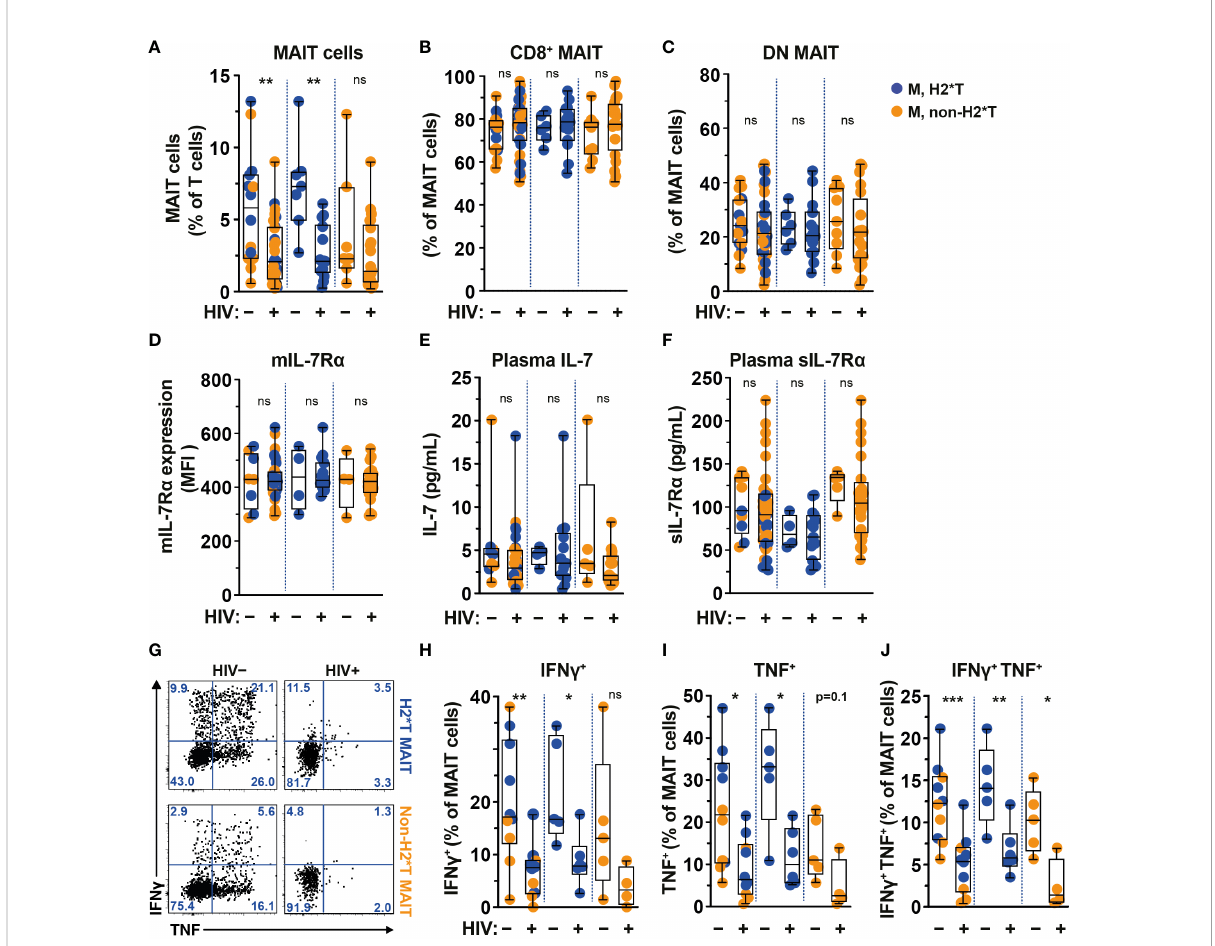
FIGURE 3 Comparison of MAIT cells in HIV-1-uninfected and -infected individuals with long-term viral suppression and their relationship with the IL7RA SNP. (A – E) V a 7.2 + CD161 hi MAIT cell levels (A) , the distribution of CD8 + (B) and CD4 - CD8 - (DN; C ) MAIT cell subsets, and membrane-bound (m)IL-7R a (D) levels by MAIT cells in HIV-1-uninfected and HIV-1-infected individuals carrying the different IL7RA haplotypes. (E, F) Plasma levels of IL-7 (E) and soluble (s)IL-7R a (F) in HIV-1-uninfected and HIV-1-infected individuals individuals bearing the different IL7RA haplotypes. (G – J) Representative fl ow cytometry gating strategy (G) to enumerate IFN g (H) , TNF (I) , and dual IFN g -TNF (J) production by MAIT cells following 24 h stimulation with formaldehyde- fi xed E coli (bacterial dose 1 CFU/cell). Box and whisker plots show all data points ( A – F : HIV-1-uninfected N=8- 14, N=4-7 for both haplotype 2 and non-haplotype 2; HIV-1-infected N=34-39, N=14-15 for haplotype 2 and N=20-24 for non-haplotype 2; H – J : HIV-1-uninfected N=10, N=5 for both haplotype 2 and non-haplotype 2; HIV-1-infected N=10, N=6 for haplotype 2 and N=4 for non- haplotype 2), median, and the interquartile range. Statistical signi fi cance was determined using Mann-Whitney ’ s test. *** p<0.001,** p<0.01,* p<0.05. ns, not signi fi cant. M, male; H2*T, IL7RA haplotype 2. Male HC dataset were retrieved from HC cohort depicted in Figure